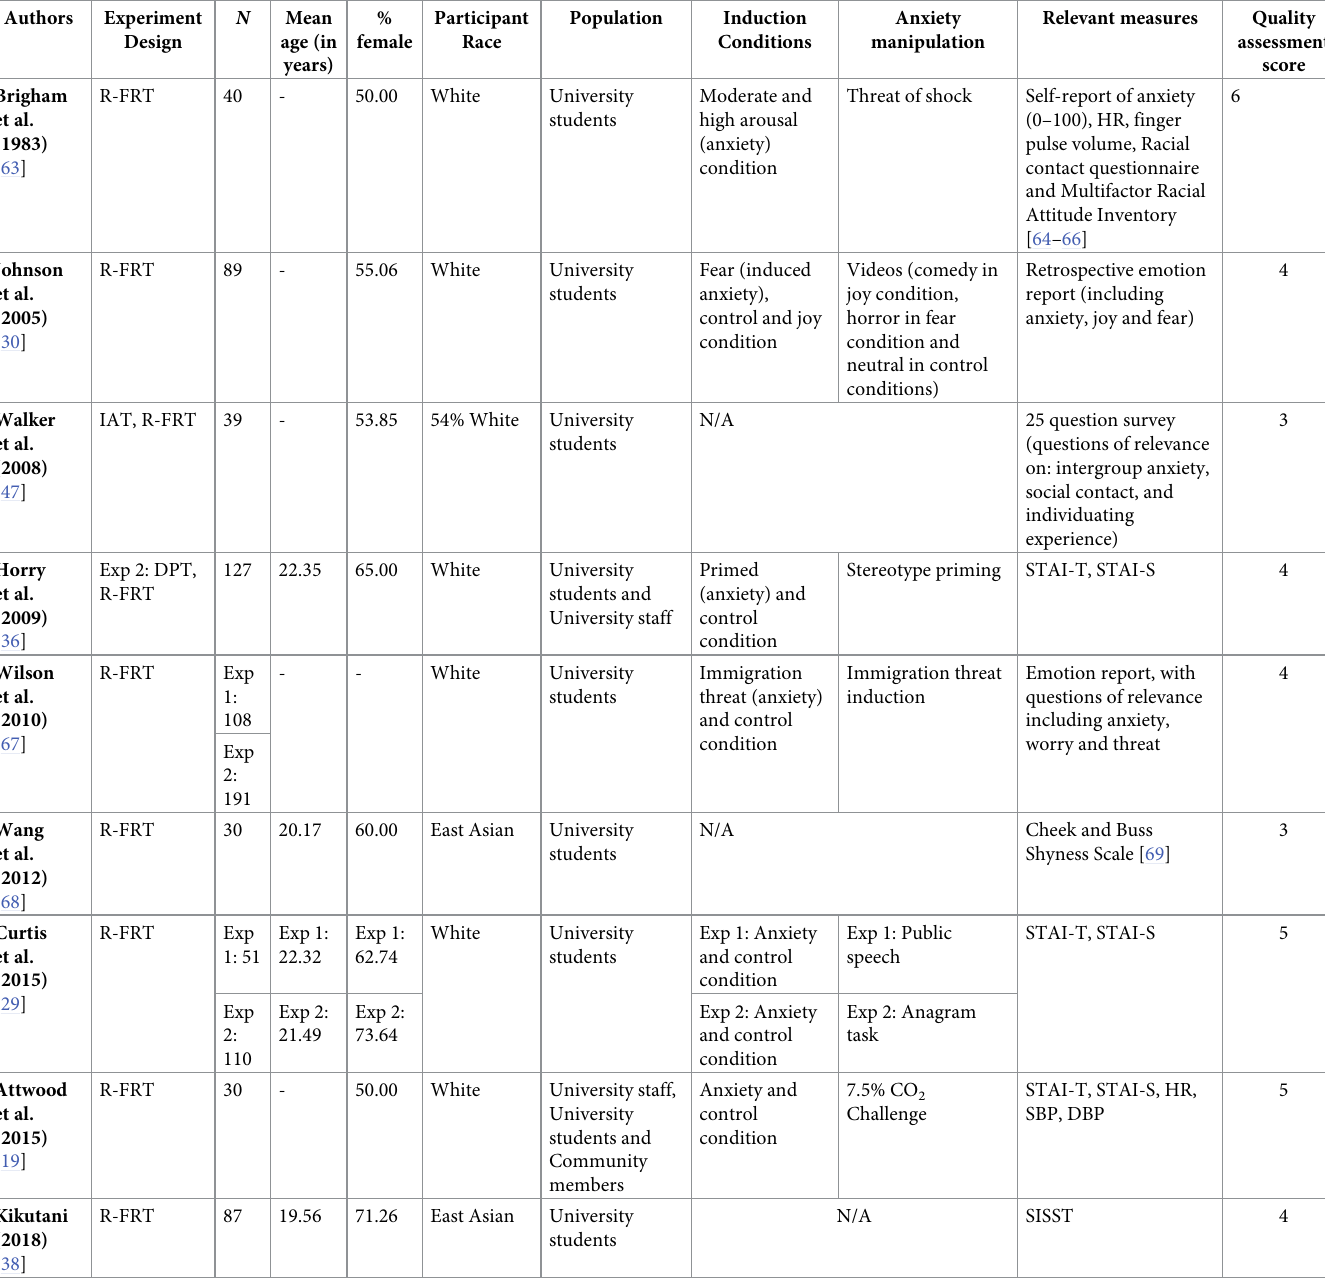
Table 1. Characteristics of included studies examining the impact of the potential interaction between anxiety and race on face-recognition accuracy.